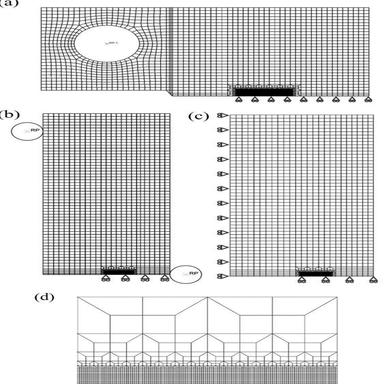
The mesh of crack growth model for (a) CT, (b) SENB and (c) MT specimens, (d) refined mesh for crack tip.